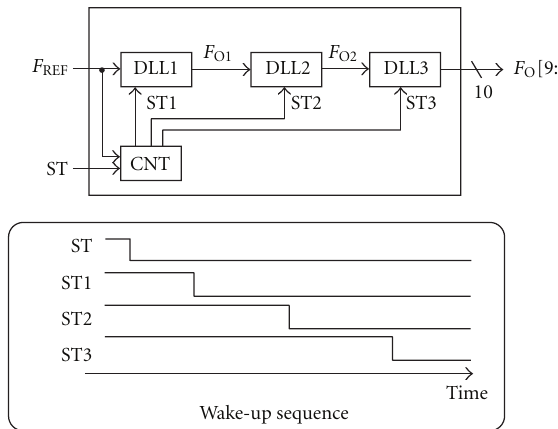
Figure 4: Proposed clock generator consisting of three DLLs and wake-up sequence. The DLL1 and DLL2 have multiplication ration of two and eight, respectively.